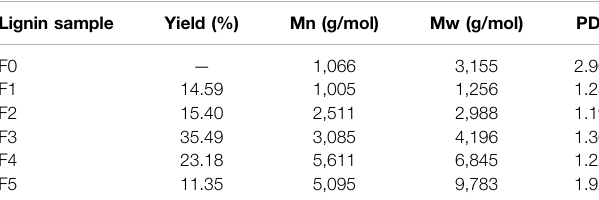
TABLE 1 | Yields and molecular weight distributions of lignin